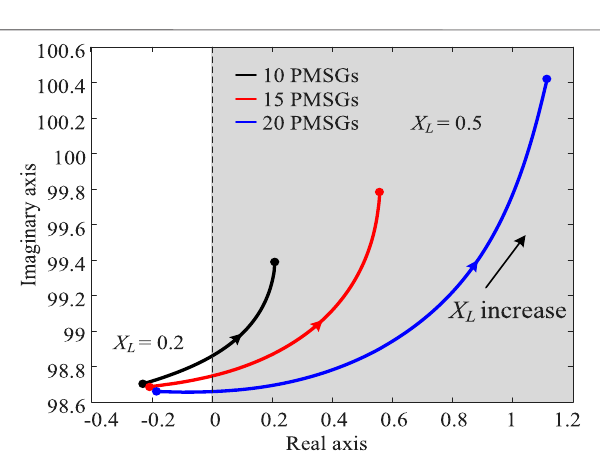
FIGURE 12 | Root loci of λ 1 with change in X L under different number of